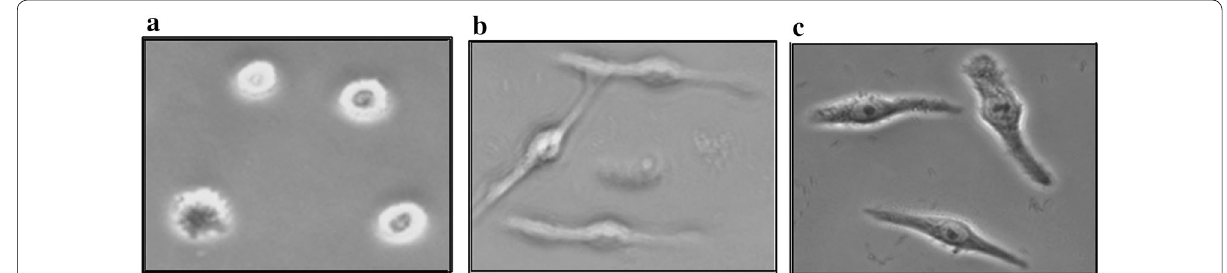
Fig. 3 CHO-K1 cells elongation activity of in vitro assembled holotoxins: ability of the rLTB.Etx 40–62 to form functional holotoxin was adjudged by incubating CHO-K1 cells with in vitro assembled holotoxins. CHO-K1 cells (1 10 4 cells/well/100 µl) in a 96 well plate were treated with the × reconstituted holotoxins (10 ng/ml) for 16 h at 37 °C in the presence of 1% fetal calf serum under 5% CO 2 humidified conditions and visualized under light microscope ( 100). a PBS-treated CHO-K1 cells (negative control). b In vitro assembled holotoxin comprising rLTA and wild type rLTB × (positive control). c In vitro assembled holotoxin comprising rLTA and rLTB.Etx 40–62 fusion protein